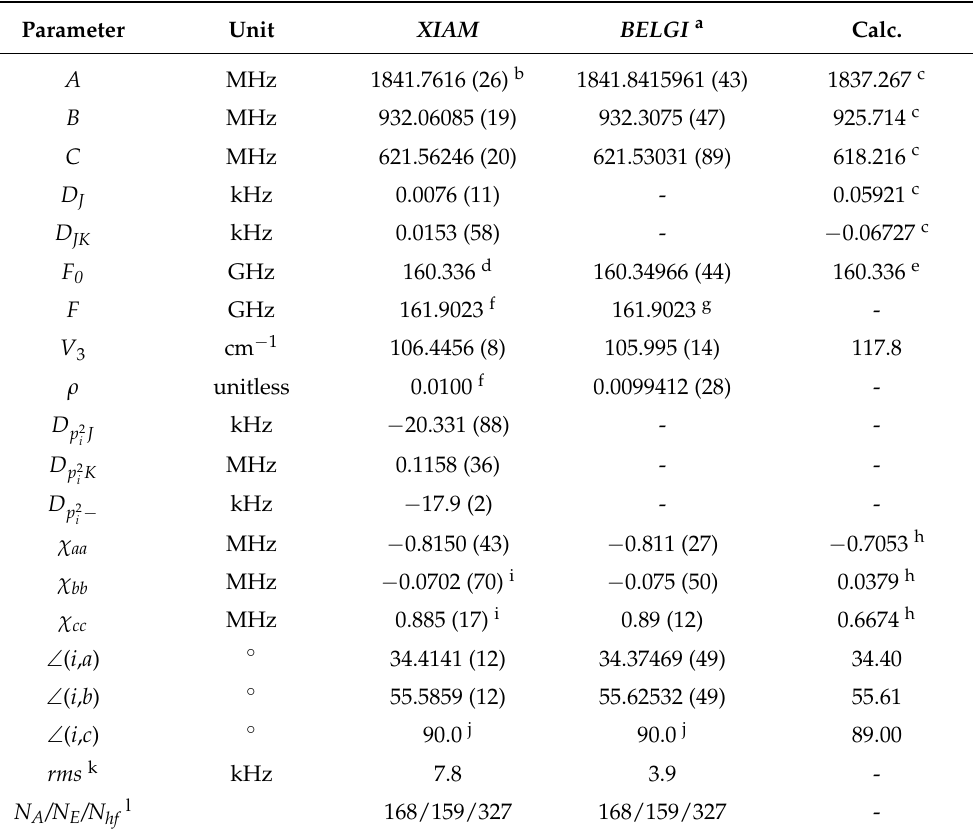
Table 2. Molecular parameters of 4MNP-1 in the PAM system obtained from fits with XIAM and BELGI-C s -hyperfine